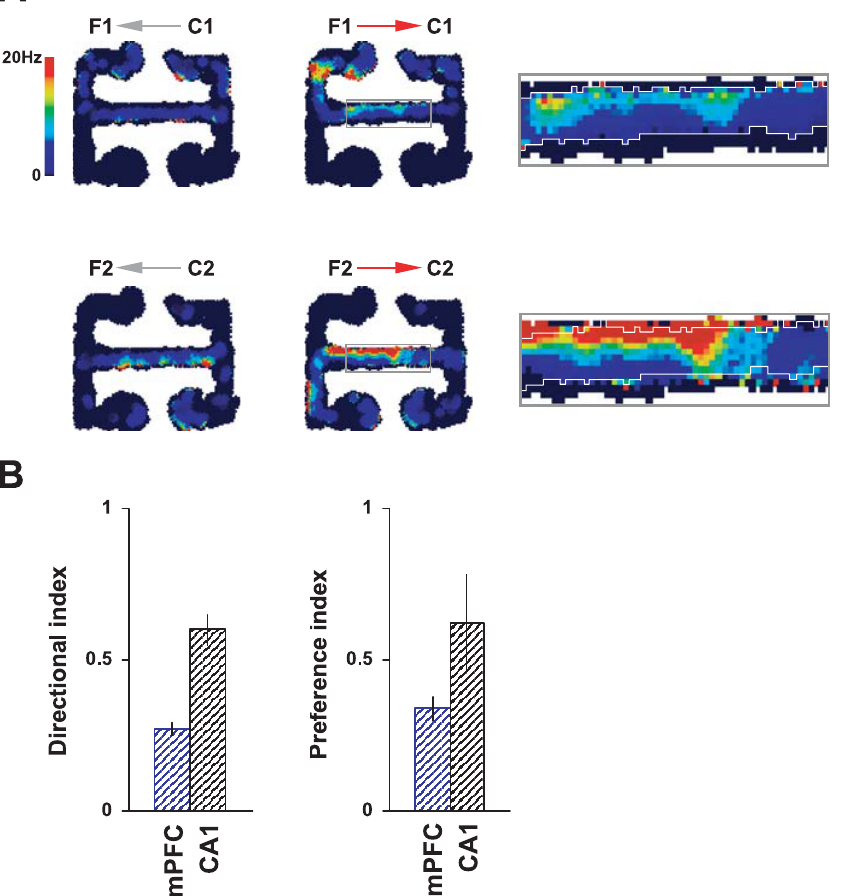
Figure 3. Directional Bias of mPFC and CA1 Firing Rates (A) Firing rate of a single mPFC neuron split into four trial types (shown by arrows). This neuron tended to fire at higher rates during runs in the choice direction, with the central arm firing highest during F2 ! C2 trials. The magnified boxes show the central three-quarters section of the central arm. White lines mark the boundary of the positional pixels traversed by the rat on F1 ! C1 trials. These are superimposed on the firing-rate map for F2 ! C2 trials, showing the overlap between positions visited on both trial types. (B) Central-arm firing rates of both mPFC (blue) and CA1 (black) neurons tended to distinguish between runs in the forced-turn and choice directions (directional index . 0) and choice-direction runs in either F1 ! C1 or F2 ! C2 trials (preference index . 0; see Results). However, there was no overall tendency for CA1 or mPFC populations to fire at higher rates during any one epoch or trial type. DOI: 10.1371/journal.pbio.0030402.g003